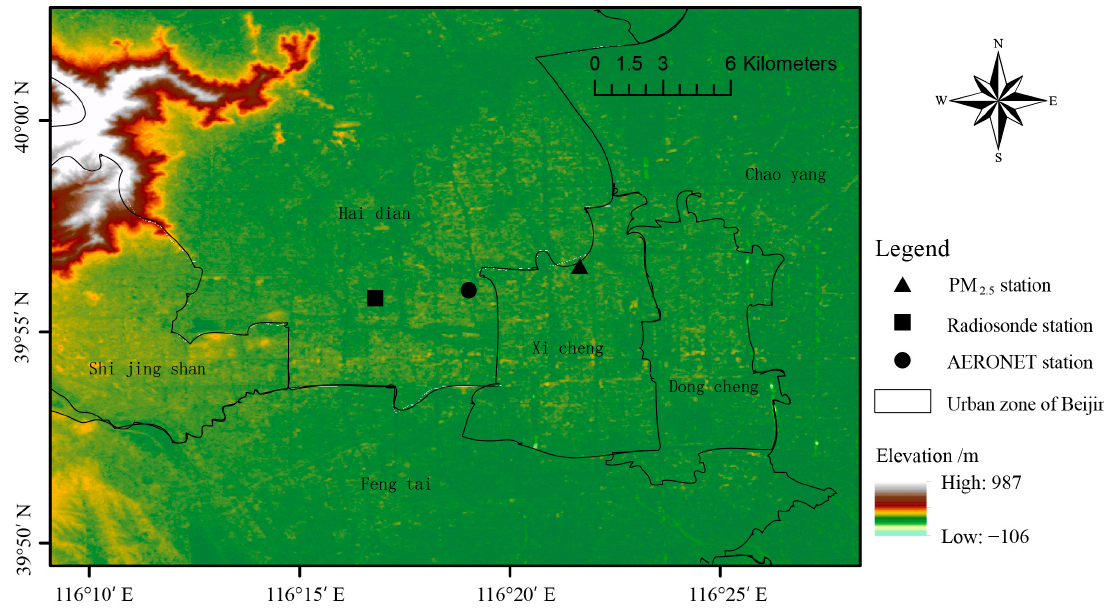
Figure 1. The spatial distribution of the PM 2.5 station, radiosonde station and Aerosol Robotic Network (AERONET) station used in this study.